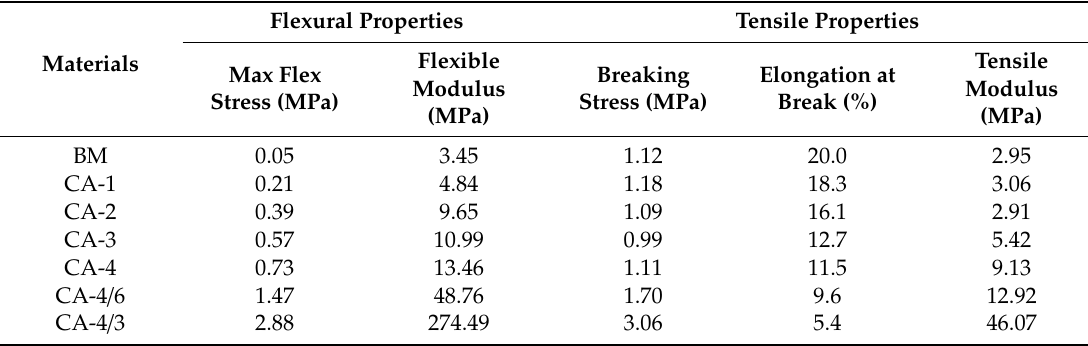
Table 2. Flexural and tensile mechanical properties of the CAs